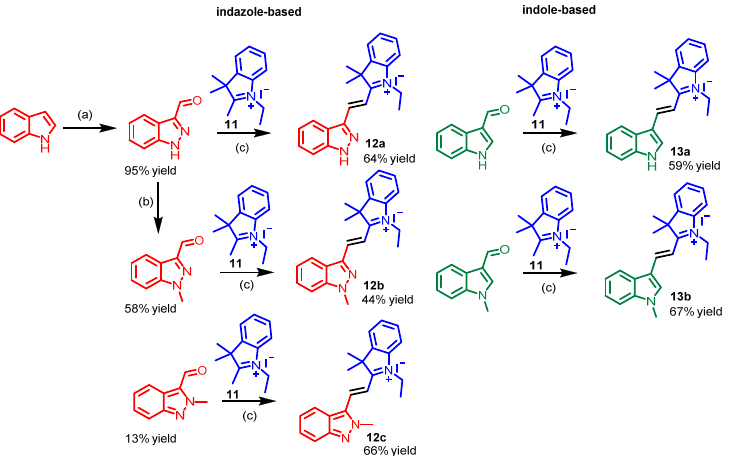
Figure 10. Confocal fluorescence images of HeLa cells stained with probes 10a – c . ( a ) Bright field images, ( b ) rows 1 and 2: probe 10a – b fluorescence under a red channel, row 3: probe 10c fluores- cence under a green channel, ( c ) rows 1 and 2: MitoTracker Green FM fluorescence under a green channel, row 3: MitoTracker Red CMXRos fluorescence under a red channel. ( d ) Merged images. Adapted from [33].